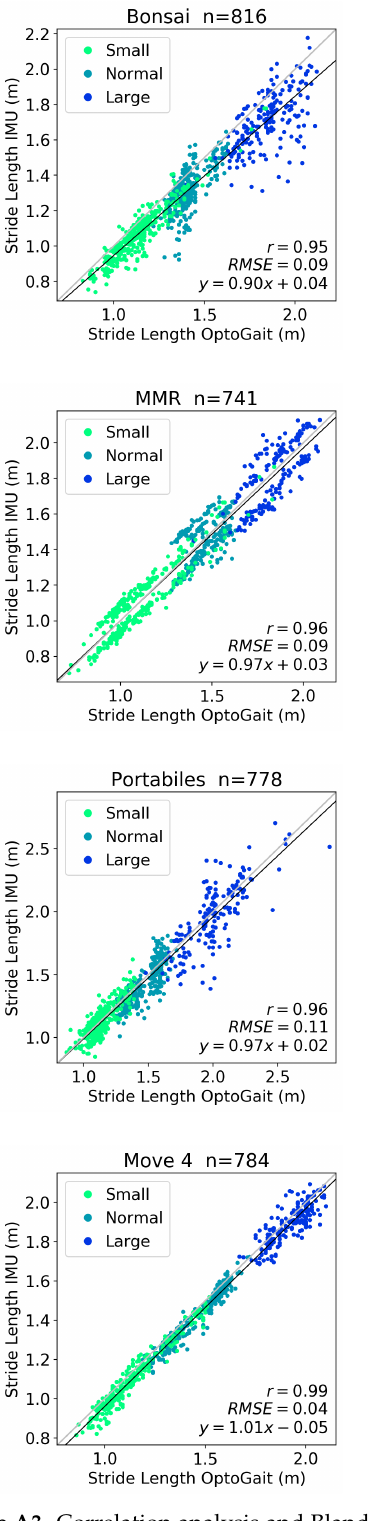
Figure A3. Correlation analysis and Bland–Altman plots of stride lengths from IMU and OptoGait. r: correlation coefficient, RMSE: root mean square error, LoA: average limits of agreement at ± 1.96 standard